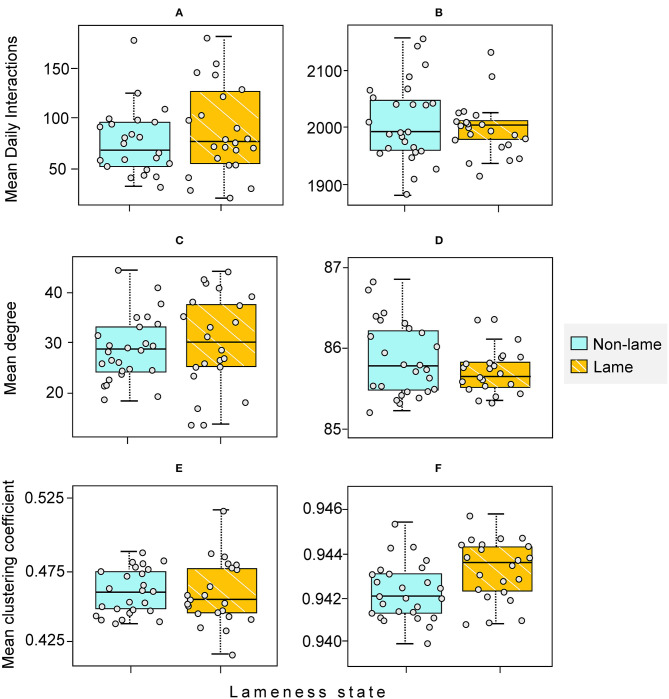
Comparison of Mean Daily Interactions and node-level measures (degree and clustering coefficient) between non-lame (NL) (n = 26) and lame (L) (n = 22) cows. (A,C,E) feeding zone; (B,D,F) non-feeding zone. The horizontal line in each boxplot represents the median value. The mean [standard deviation] values for NL and L cows are given, respectively by: (A) 74 [35] and 90 [44]; (B) 2015 [70] and 2006 [45]; (C) 27.92 [8.53] and 30.14 [9.37]; (D) 85.85 [0.45] and 85.68 [0.26]; (E) 0.44 [0.09] and 0.46 [0.02]; (F) 0.94 [0.001] and 0.94 [0.001]. Each individual cow is indicated with a small circle.